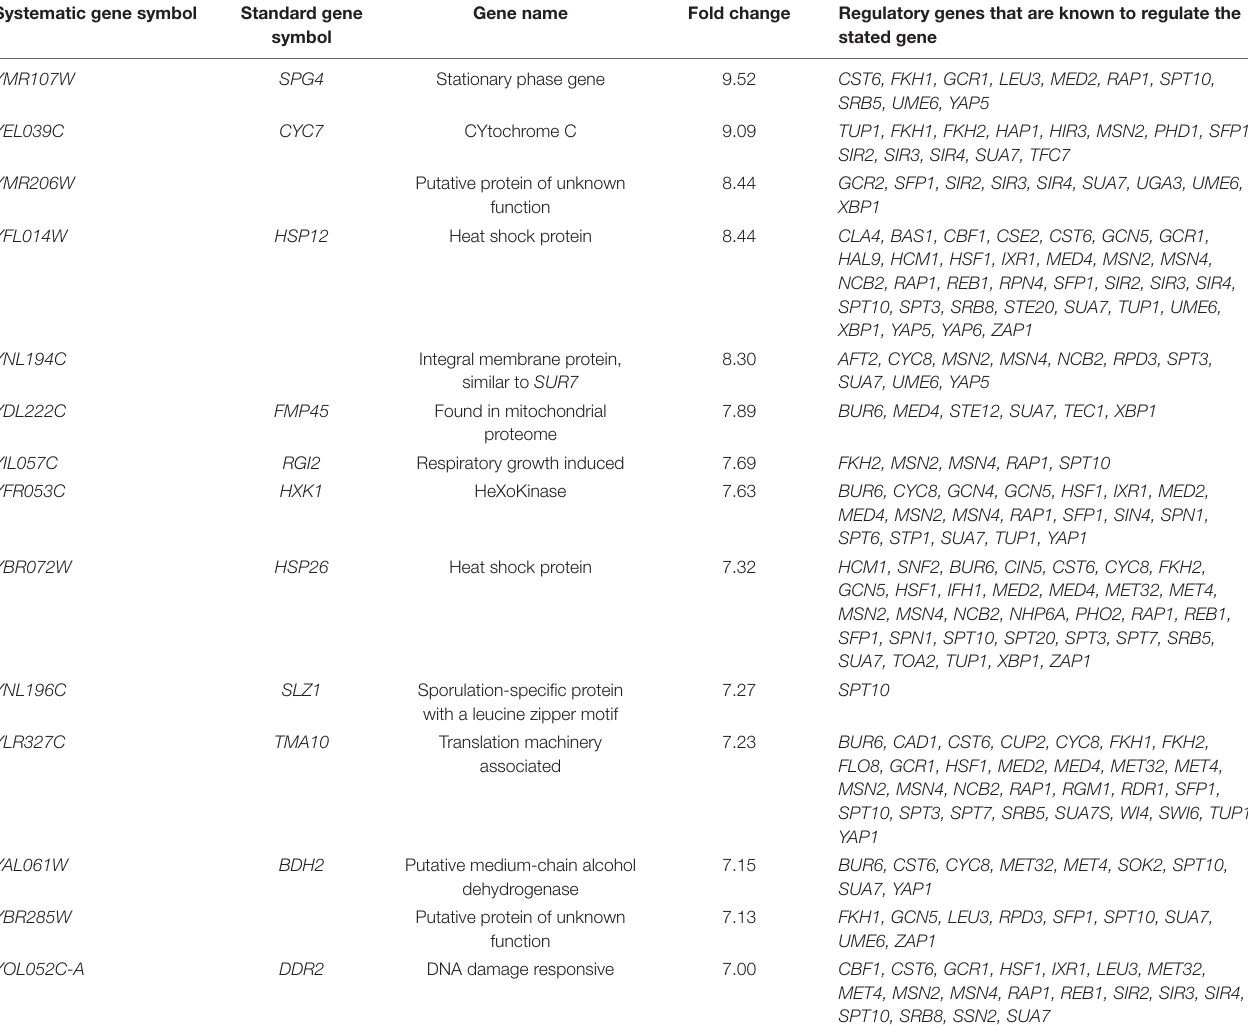
TABLE 2 | Genes which were up-regulated by at least sevenfold in H7.